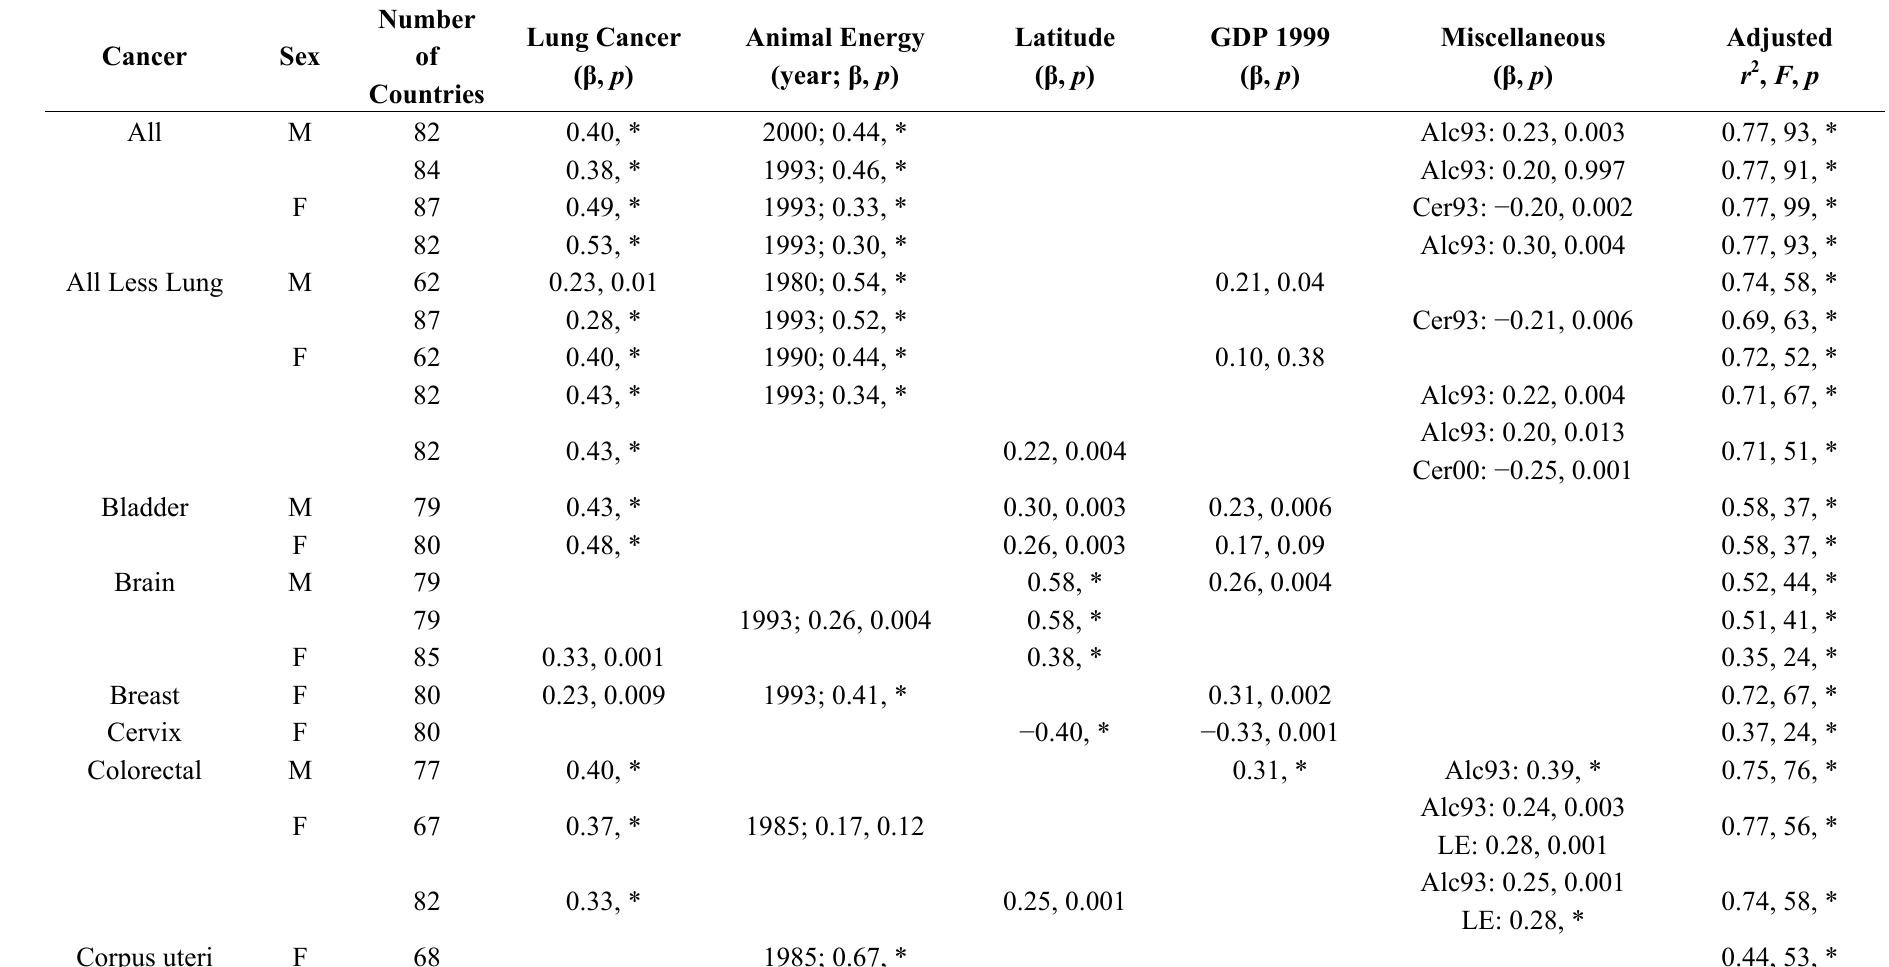
Table 2. Regression results for 87 high quality